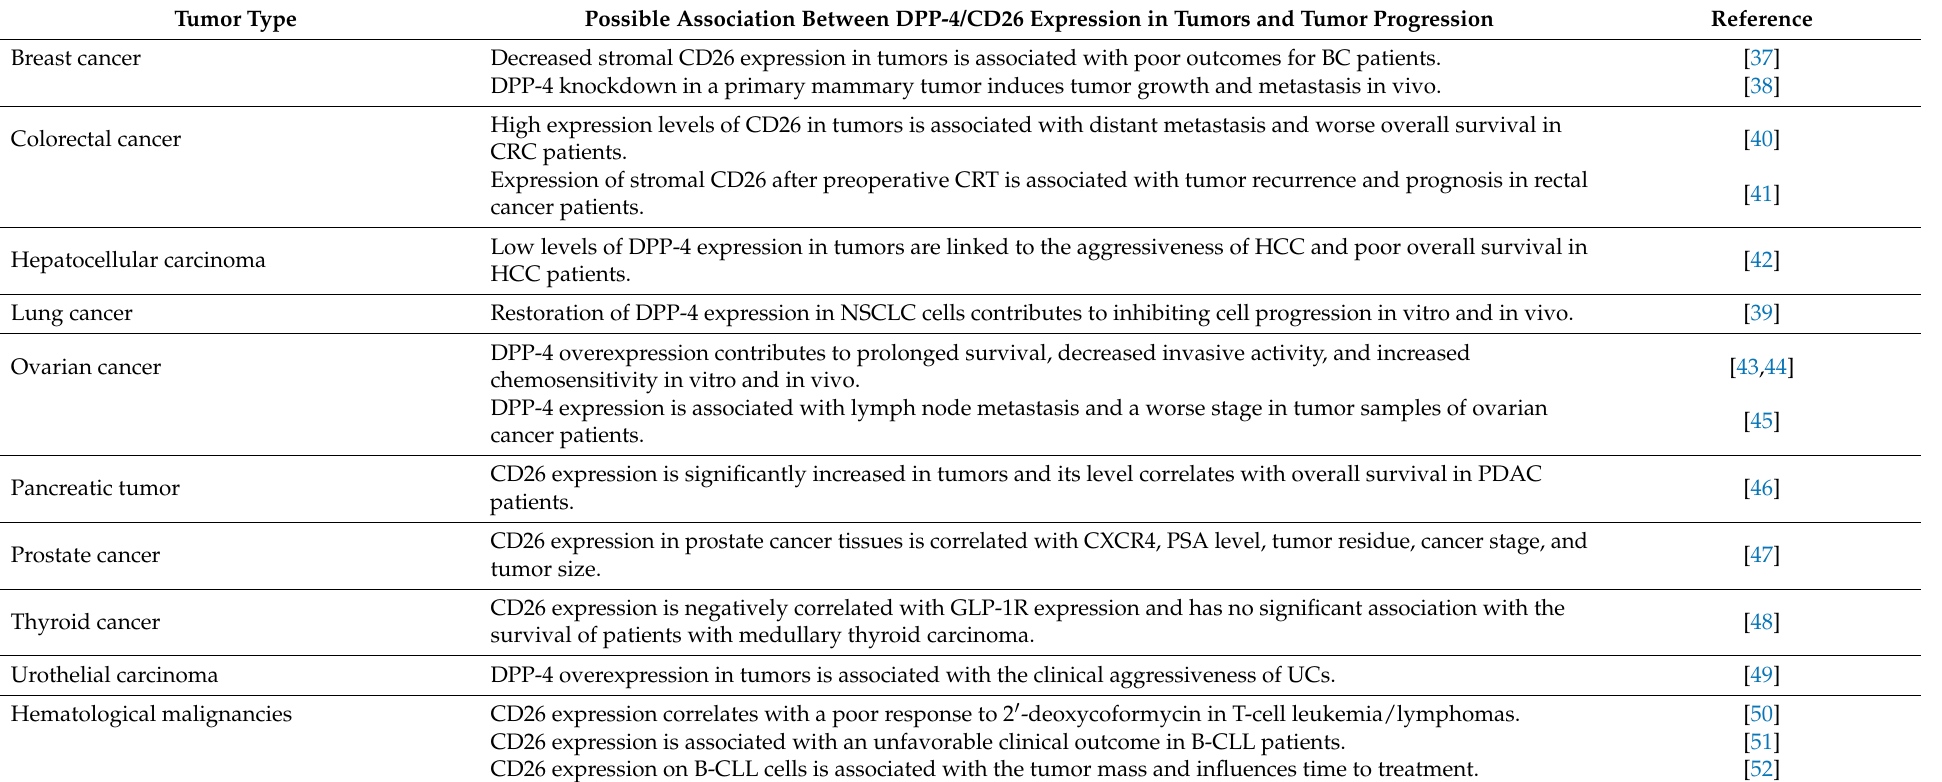
Table 1. DPP-4/CD26 expression in primary tumors and its role in cancer progression